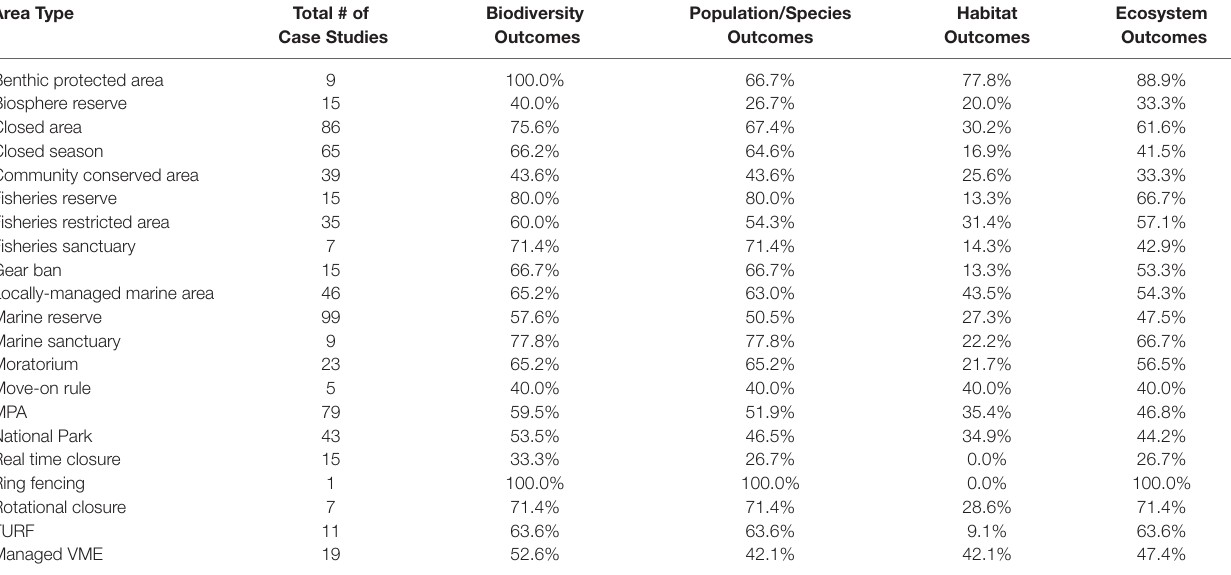
TABLE 5 | Summary of case studies with documented positive biodiversity outcomes by category of fisheries ABMT.